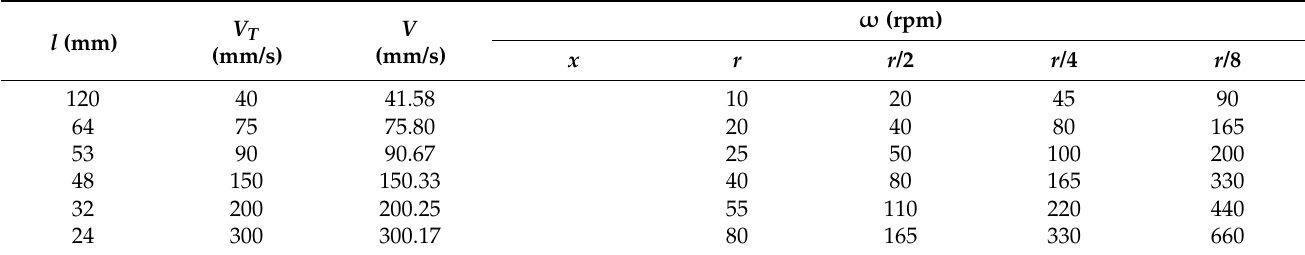
Table 1. Twenty-four polishing conditions used in experimental and modelling work, obeying conditions 1 and